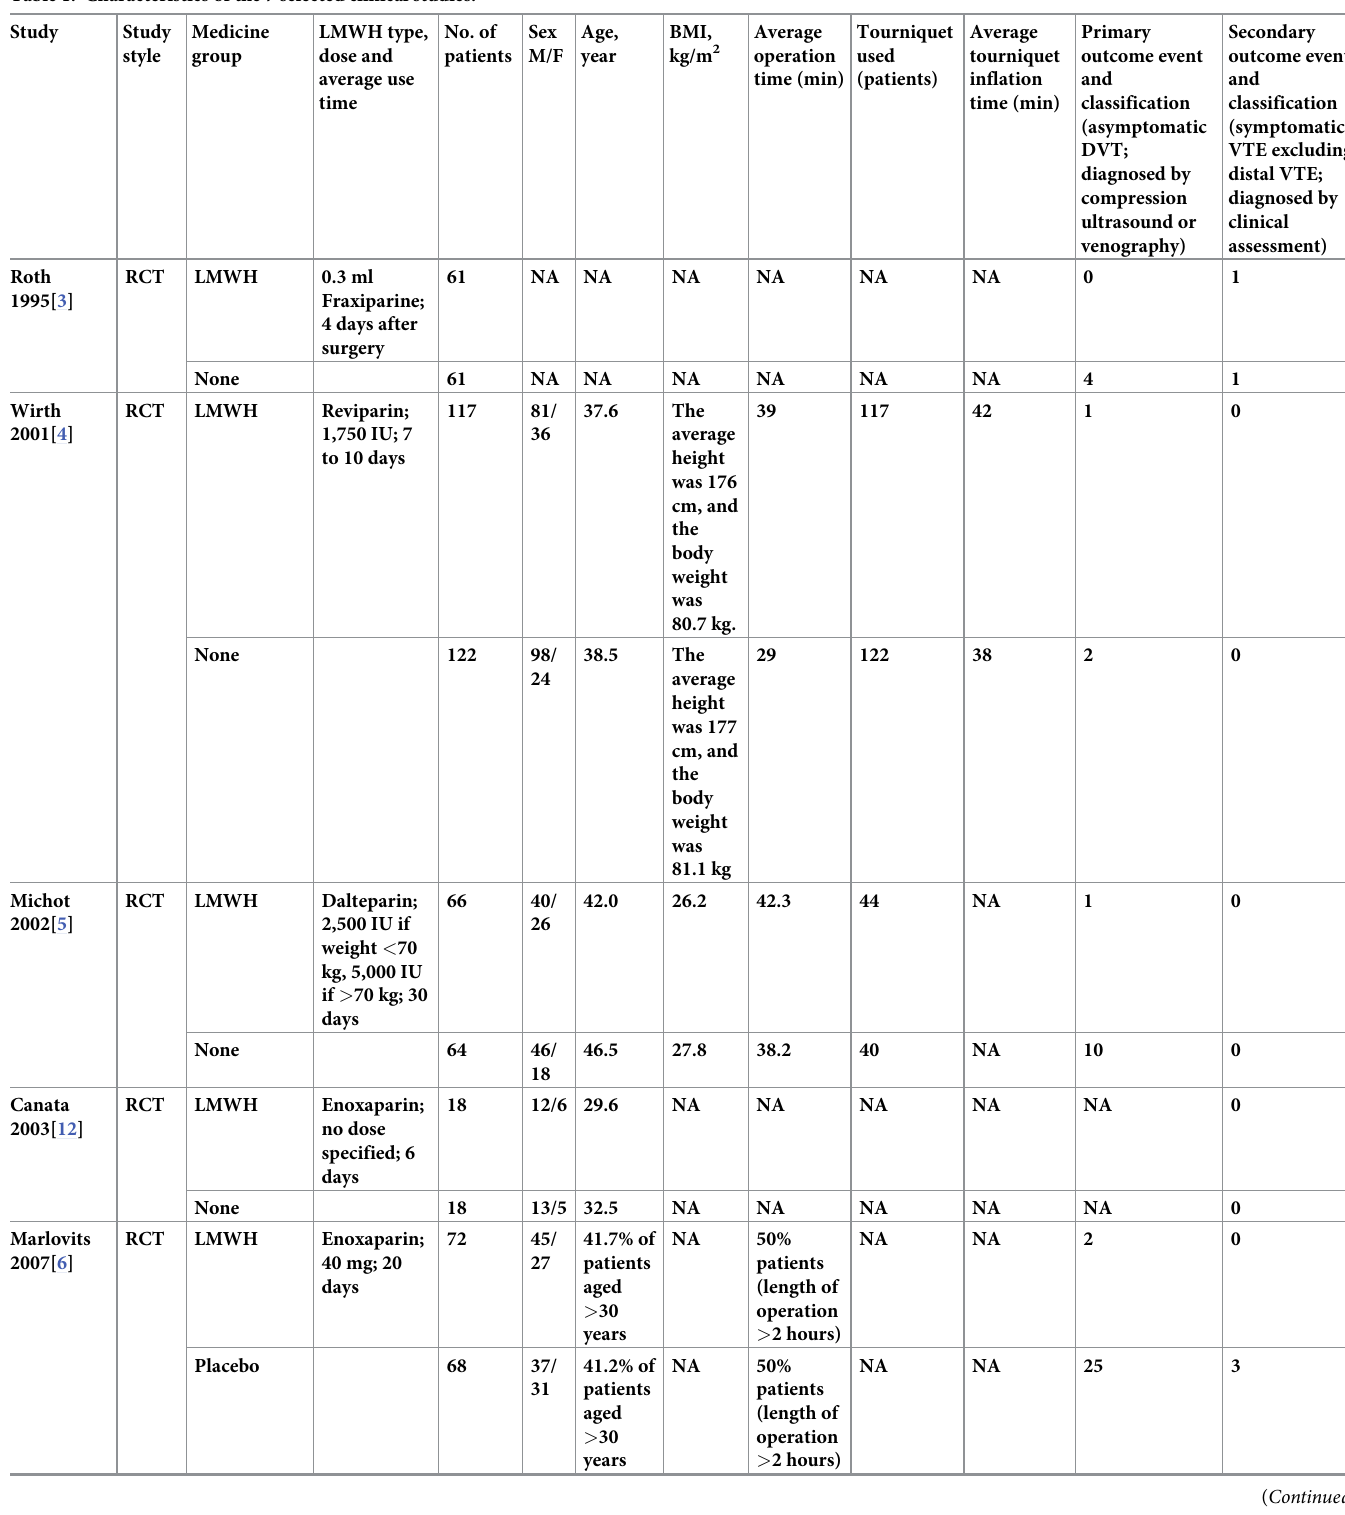
Table 1. Characteristics of the 7 selected clinical